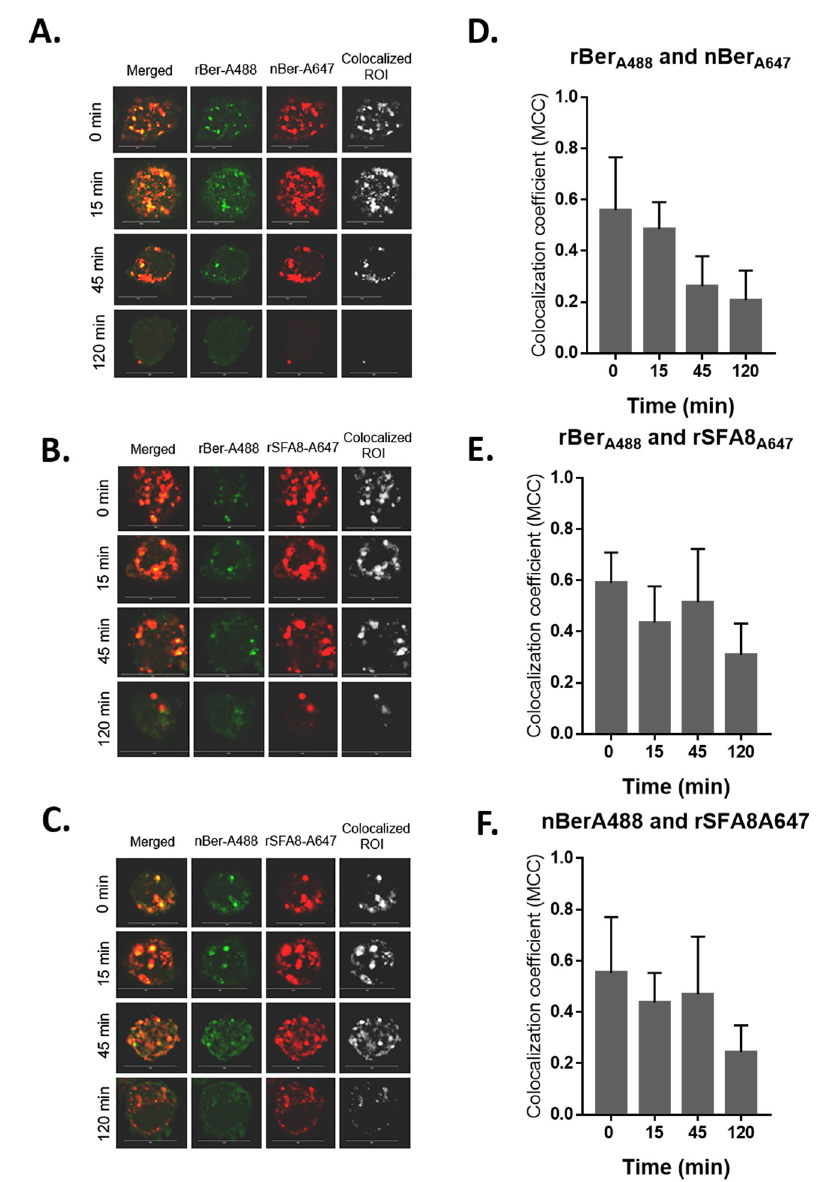
Fig 5. Confocal fluorescence imaging of CD11c + bmDC for colocalization analysis. The colocalization between (A.) rBer e 1-A488 (green) and nBer e 1-A647 (red), (B.) rBer e 1-A488 (green) and rSFA8-A647 (red) and (C.) rBer e 1-A488 (green) and rSFA8-A647 (red), were visualised at different chasing times (0 min, 15 min, 45 min, and 120 min). Gradual reduction of fluorescent-labelled rBer e 1, nBer e 1, and rSFA8 in bmDC were observed over time. Bright spots of colocalized ROI represent areas where both proteins co-occurred. Scale bar for all images = 10 μ m. Colocalization after different chasing times were compared for co-occurred regions representing overlapped of the two fluorescent labelled proteins in puncta and measured as MCC. MCC for fractional overlap of A488-labelled proteins and A647-labelled proteins were compared in graphs (D.–F.). value of 0.557 ± 0.208 indicates that about 56% rBer e 1 colocalized with nBer e 1 at distinct puncta. After 15 minutes, the MCC values dropped slightly to 0.48 ± 0.11 (Fig 5D). Post 45 to 120 minutes of chasing time, the MCC values of colocalization between rBer e 1 and nBer e 1